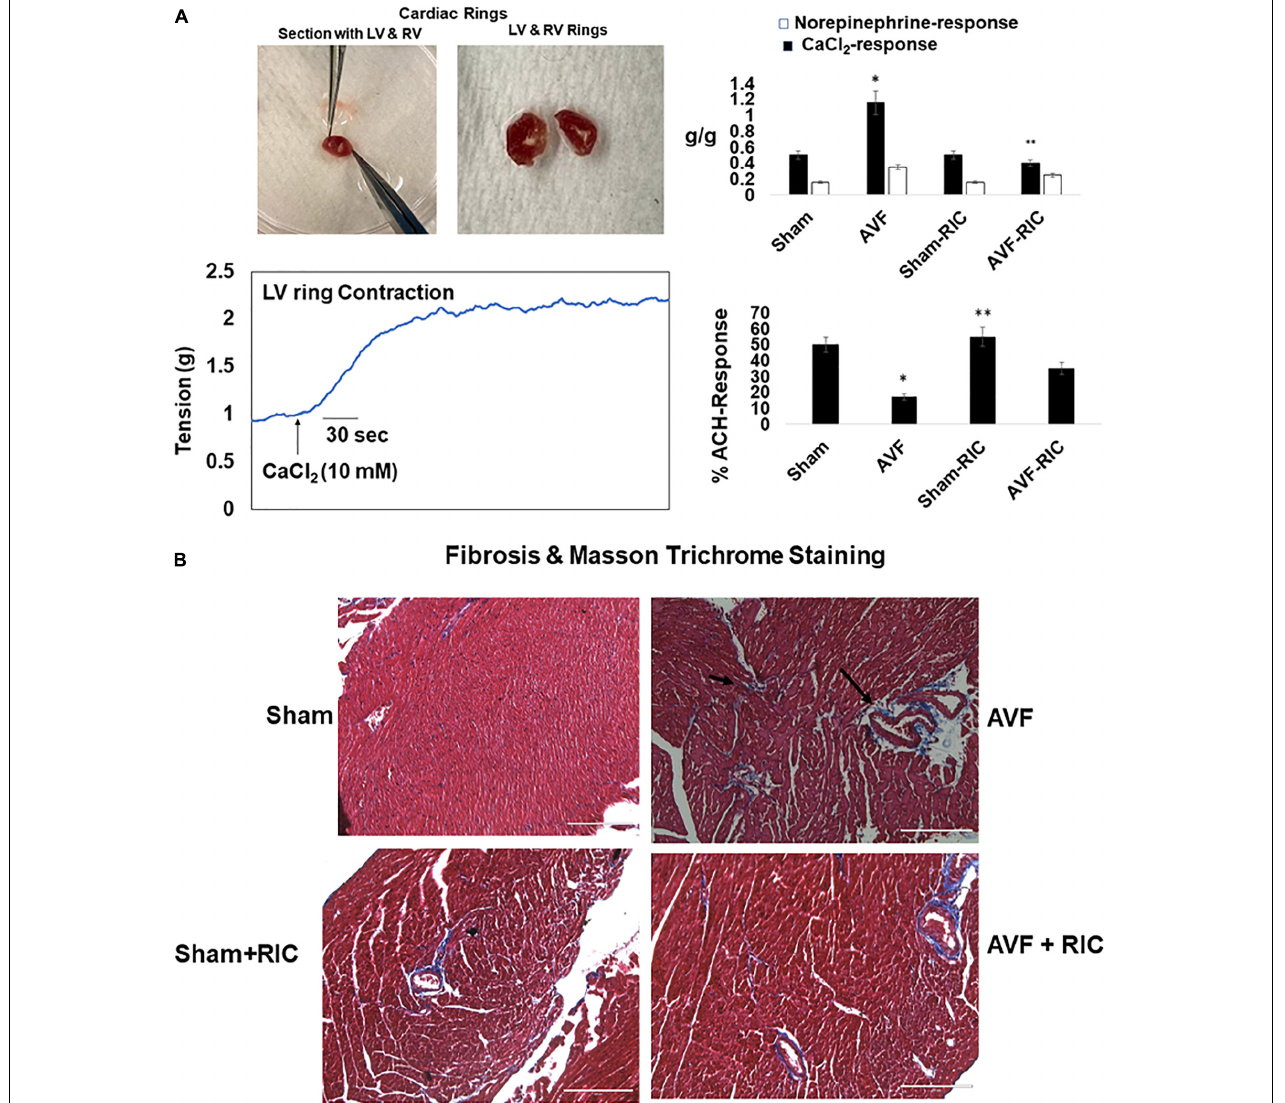
FIGURE 6 | (A) Representative ex vivo cardiac contractile (CaCl 2 and norepinephrine) (left panels) and endothelial-dependent (acetylcholine) function in cardiac left ventricle (LV) ring preparation (bottom right panel). Bar graph of relative scan unit representation with ± SD from n = 5–8. (B) The representative trichrome blue collagen fibrosis stain in sham and AVF hearts with and without RIC. * and ** indicate significant difference ( p < 0.05) either to “sham without RIC” or to “0”